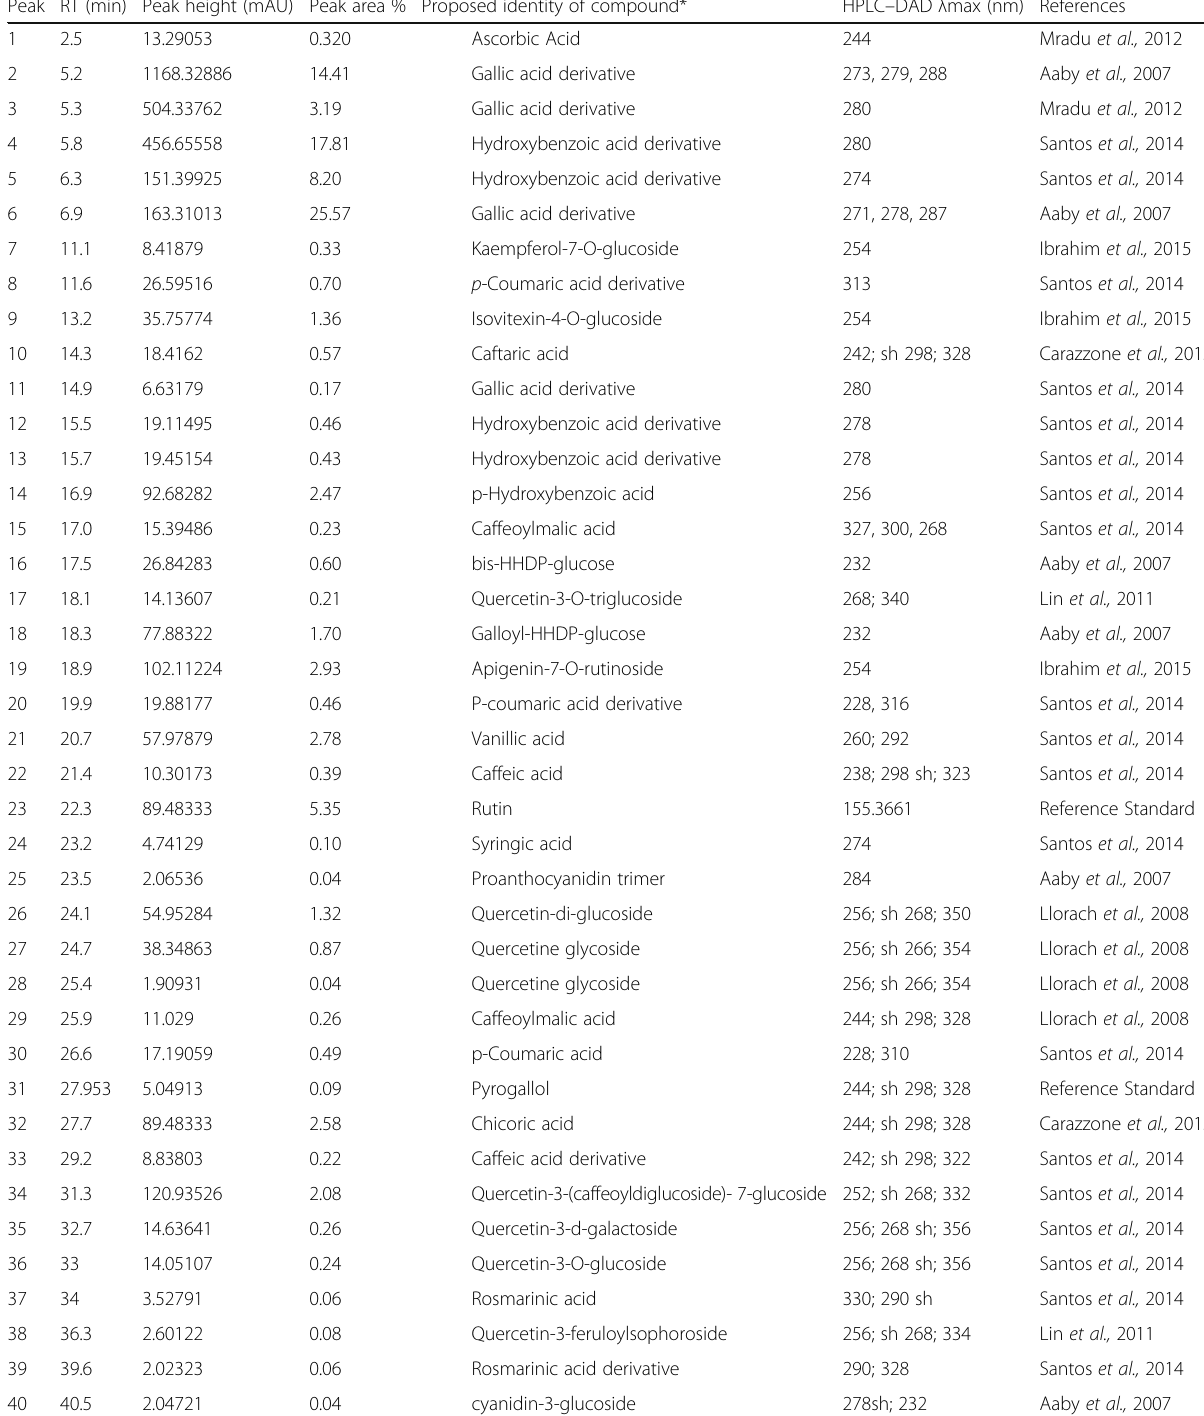
Table 2 HPLC-DAD identification of phenolic compounds in Olax nana leaves Peak RT (min) Peak height (mAU) Peak area % Proposed identity of